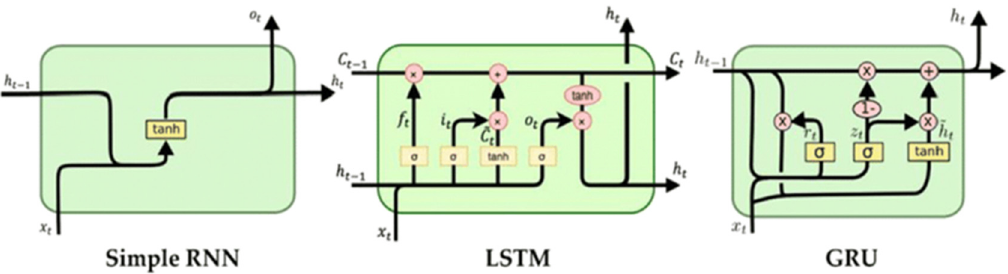
Figure 10. Network structure of RNN, LSTM, and GRU.